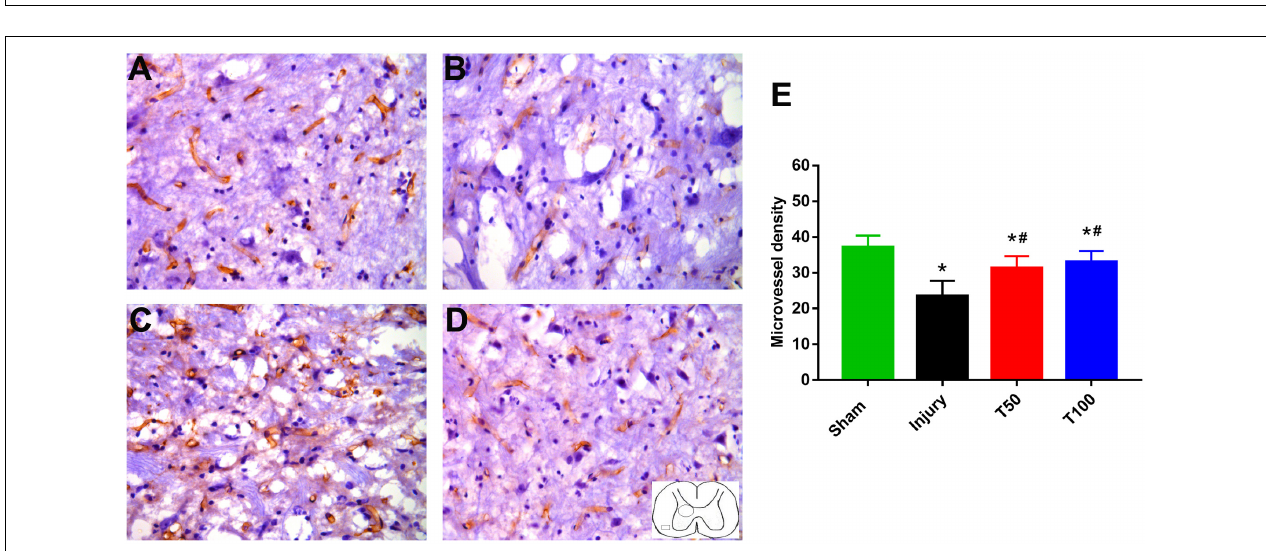
FIGURE 7 | 3D reconstruction of microvessels in the cervical spinal cord. (A) Ventral, (E) dorsal, (I) cross-sectional microvessels in Sham group; (B) ventral, (F) dorsal, (J) cross-sectional microvessels in injury group; (C) ventral, (G) dorsal, (K) cross-sectional microvessels in T50 group; (D) ventral, (H) dorsal, (L) cross-sectional microvessels in T100 group. The white arrow indicates the location of the injury.